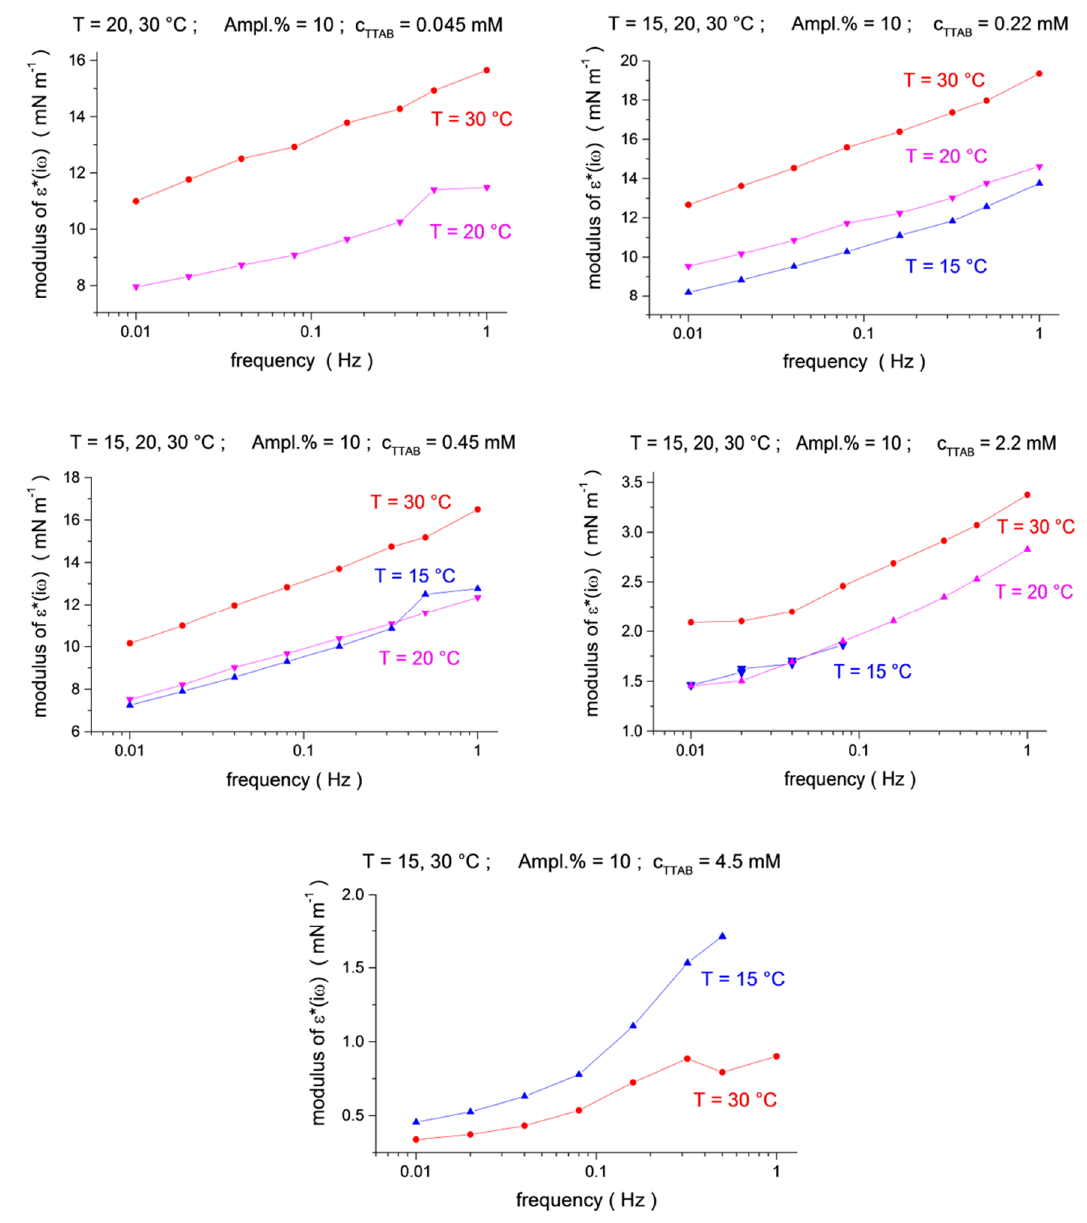
Figure 4. Temperature dependence (blue up triangles T = 15 °C, magenta down triangles T = 20 °C, red circles T = 30 °C) for the ε*(iω) modulus as a function of frequency (f = 0.01, 0.02, 0.04, 0.08, 0.16, 0.32, 0.5 and 1.0 Hz) at TTAB concentrations of c 2 = 4.5 × 10 −5 , 2.2 × 10 −4 , 4.5 × 10 −4 , 2.2 × 10 −3 and 4.5 × 10 −3 mol/dm 3 , at a fixed C 13 DMPO concentration of c 1 = 2.2 × 10 −5 mol/dm 3 .